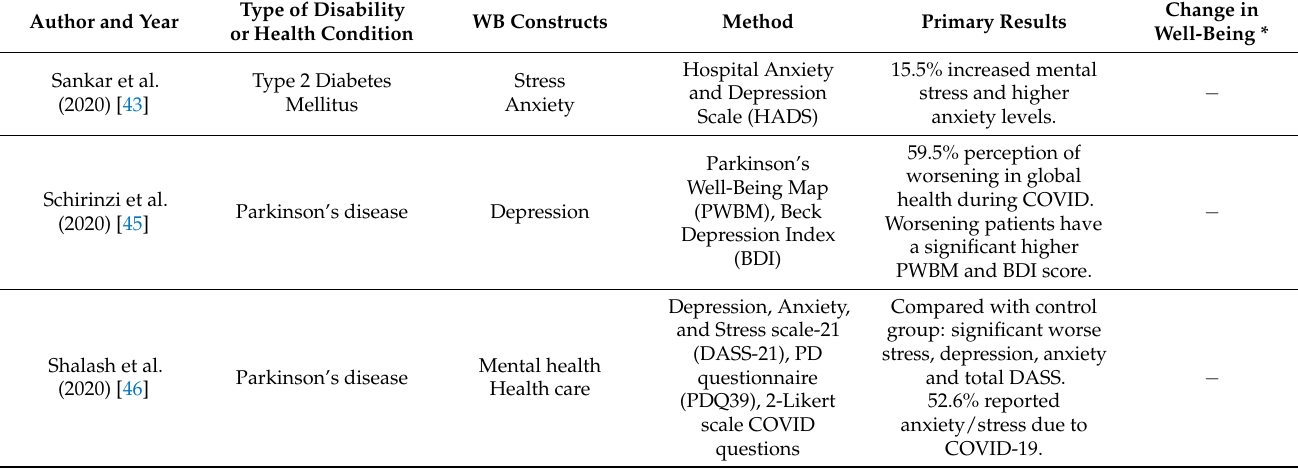
Table 5. Key findings regarding well-being during the first wave of the COVID-19